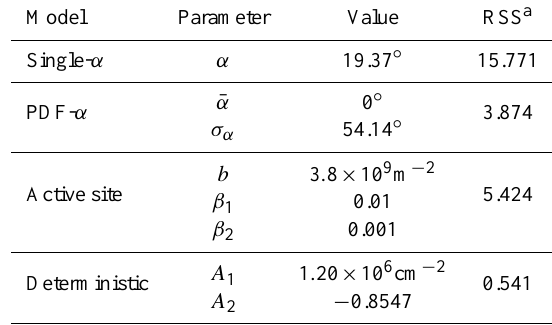
Table 1. Fit parameters obtained for kaolinite. Best fits were ob- tained by minimizing the weighted residual sum of squares between the experimental data and the fit function. See text for further dis- cussion on the models used.